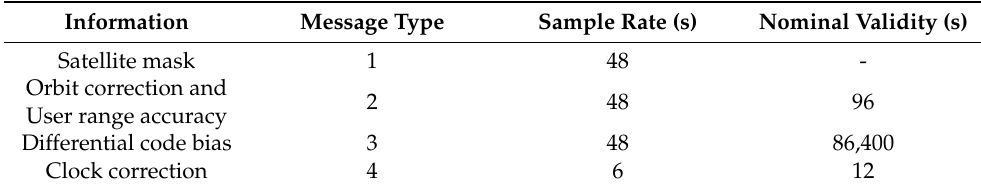
Table 2. The PPP-B2b message